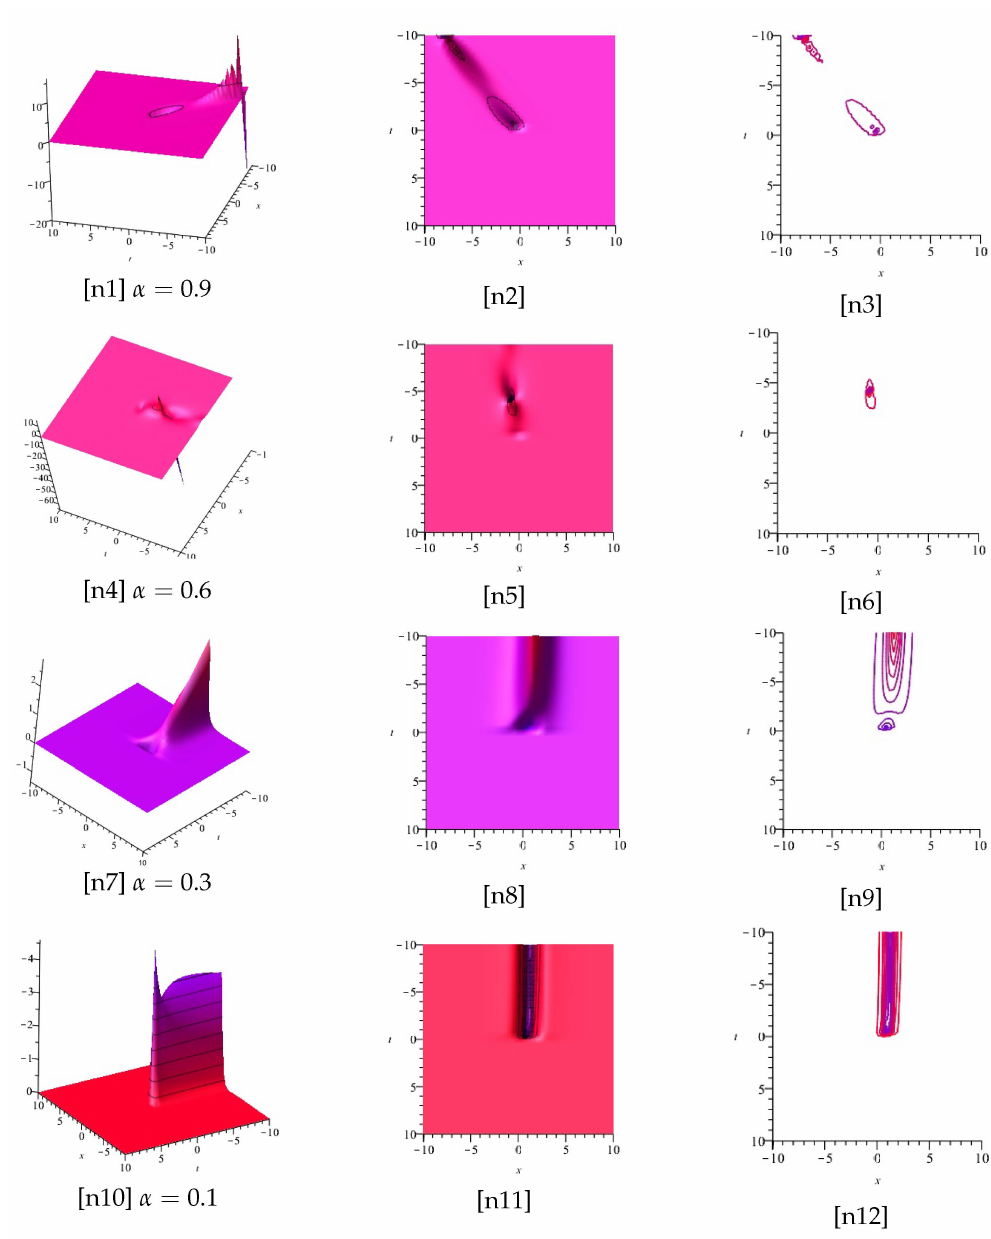
Figure 14. Now, [n1], [n4], [n7], and [n10] display the plots of the real part of Equation (38), for λη < 0, and [n2], [n5], [n8], and [n11], as well as [n3], [n6], [n9], and [n12], display the z -axis orientation and the contour plot,